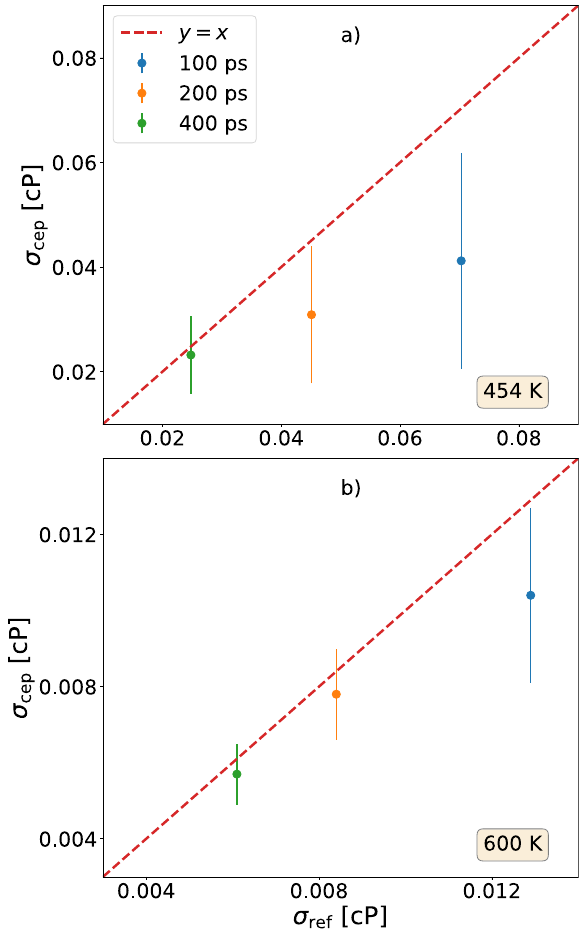
Fig. 6 Estimated standard deviations of η vs. spread of the distribution. Correlation between the cepstral estimates of the standard deviations of the viscosity of water from trajectories of different lengths and temperatures, σ cep , vs. the spread of the distribution of their values resulting from different trajectories, σ ref (see text). Error bars represent standard deviations.